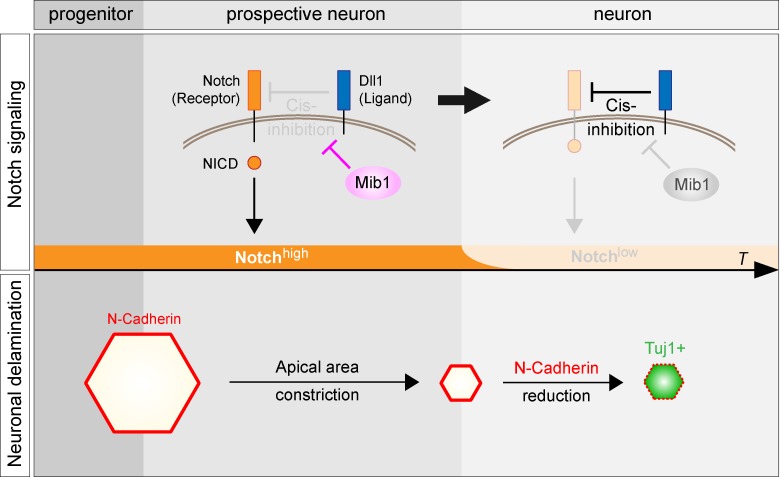
Model for the role of Mib1-dependent Notch activity in the regulation of neuronal delamination.Top: Prospective neurons maintain a high level of Notch activity until they fully differentiate. Mib1 is required during that transition phase to keep Dll1 from Cis-inhibiting the Notch receptor. This allows Notch to be Trans-activated by Dll1 present on neighboring cells (not represented here), resulting in the release of the NICD. When the Dll1/Mib1 ratio is sufficiently high, Cis-inhibition takes place and Notch activity is rapidly turned off. Bottom: Sustained Notch activity allows prospective neurons to shrink their apical area and keeps them from differentiating. As Notch activity is decreased, N-Cadherin levels are down-regulated and neuronal differentiation markers start being expressed. Dll1, Delta-like 1; Mib1, Mindbomb1; NICD, Notch intracellular domain; T, time.